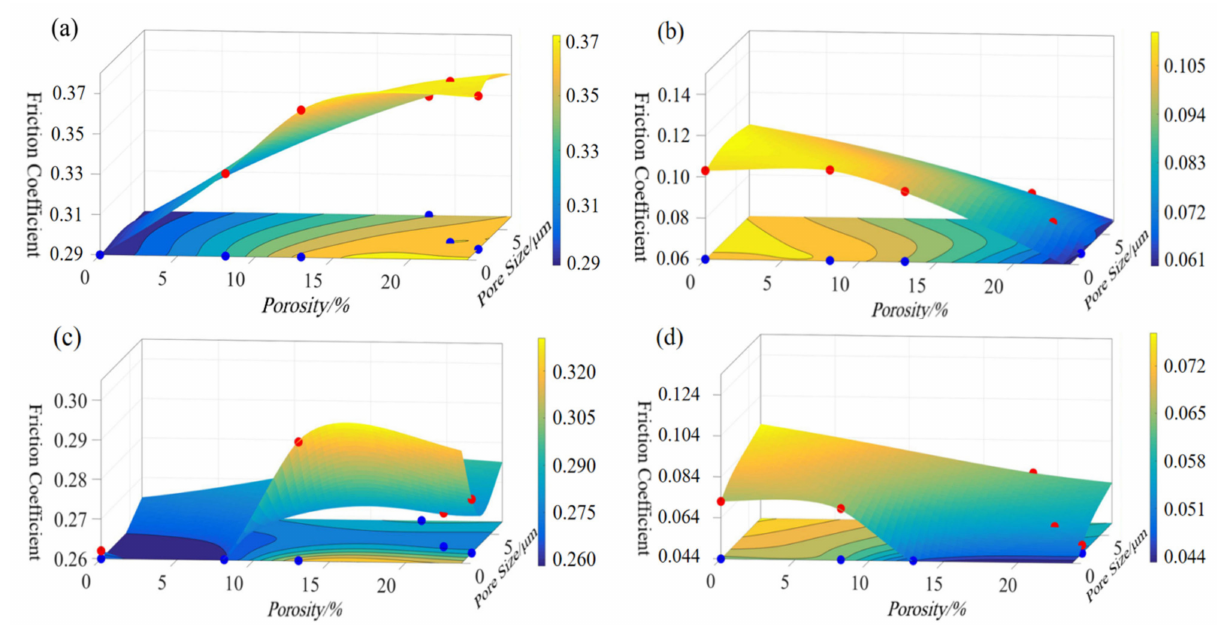
Figure 12. Average friction coefficient of all the non-heat-treated samples and heat-treated samples.